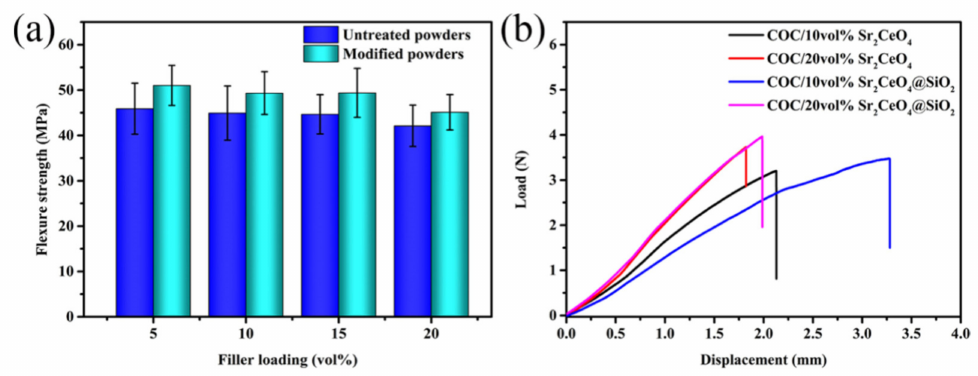
Figure 11. ( a ) The flexure strength of the composites; ( b ) the load-displacement curves of the composites.